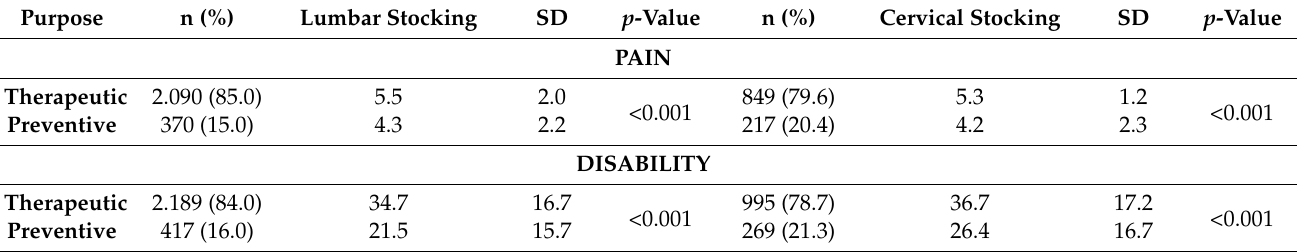
Table 4. First BS evaluation: pain and disability as a function of the purpose for which the BS was